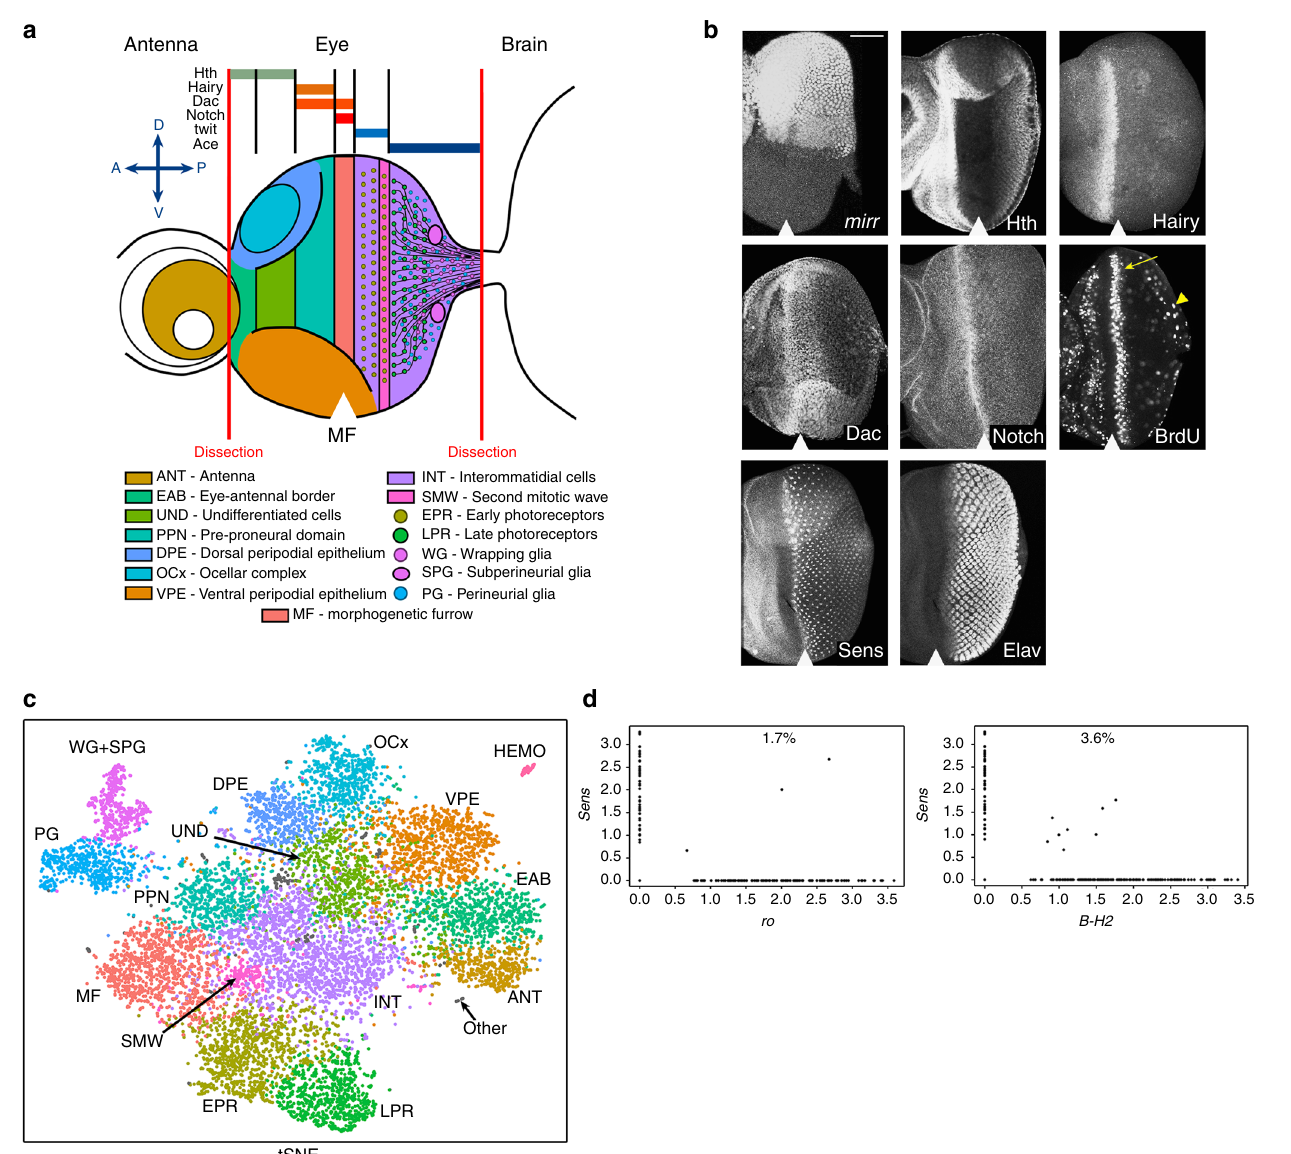
Fig. 1 A cell atlas of the wild-type third-instar larval eye disc. a A cartoon representation of the eye-antennal disc and known cell types that are color coded. The red vertical lines indicate where the dissections were made. The expression domains of genes above that were used to assign cell clusters. D dorsal, V ventral, P posterior to the MF, A anterior to the MF. b The pattern of the expression of cell-type markers in the eye as revealed by immuno fl uorescence. BrdU labeling shows the location of SMW (yellow arrow) and PG (yellow arrowhead) cells undergoing cell division. The scale bar is 50 µ m. c The tSNE representation of 11,416 wild-type eye disc cells. Each cluster represents a cell type/domain, characterized by a unique gene expression signature. Clusters are color coded as in ( a ). Other cells are labeled as gray. d Gene/gene plots generated on all photoreceptors for sens (R8) and ro (R2/5), sens and B-H2 (R1/6). The percentage represents doublets, based on the detection of two R cell-speci fi c markers in the same single-cell library. The position of the MF is shown by white